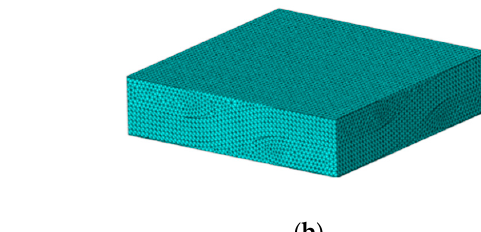
Figure 5. Stress-strain curve.